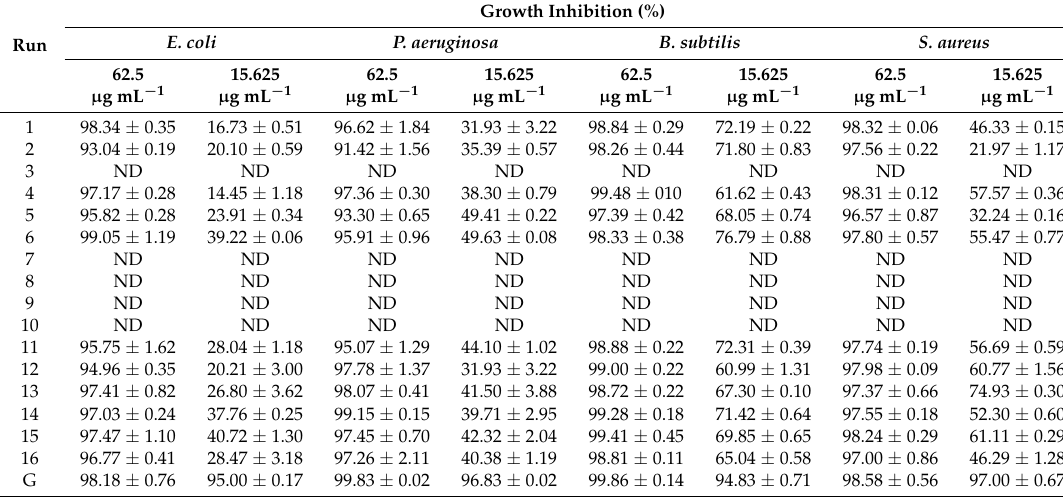
Table 7. Bacterial growth inhibition in the presence of supercritical fluid sage leaf extracts against Escherichia coli , Pseudomonas aeruginosa, Bacillus subtilis , and Staphylococcus aureus . Growth Inhibition (%) E. Run